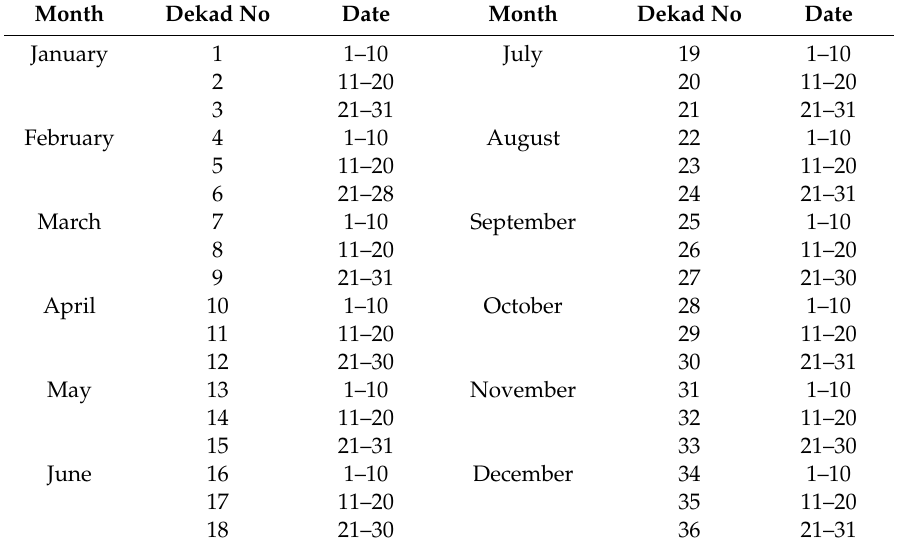
Table A1. Standard dekad numbers ([49] as cited in [50]).